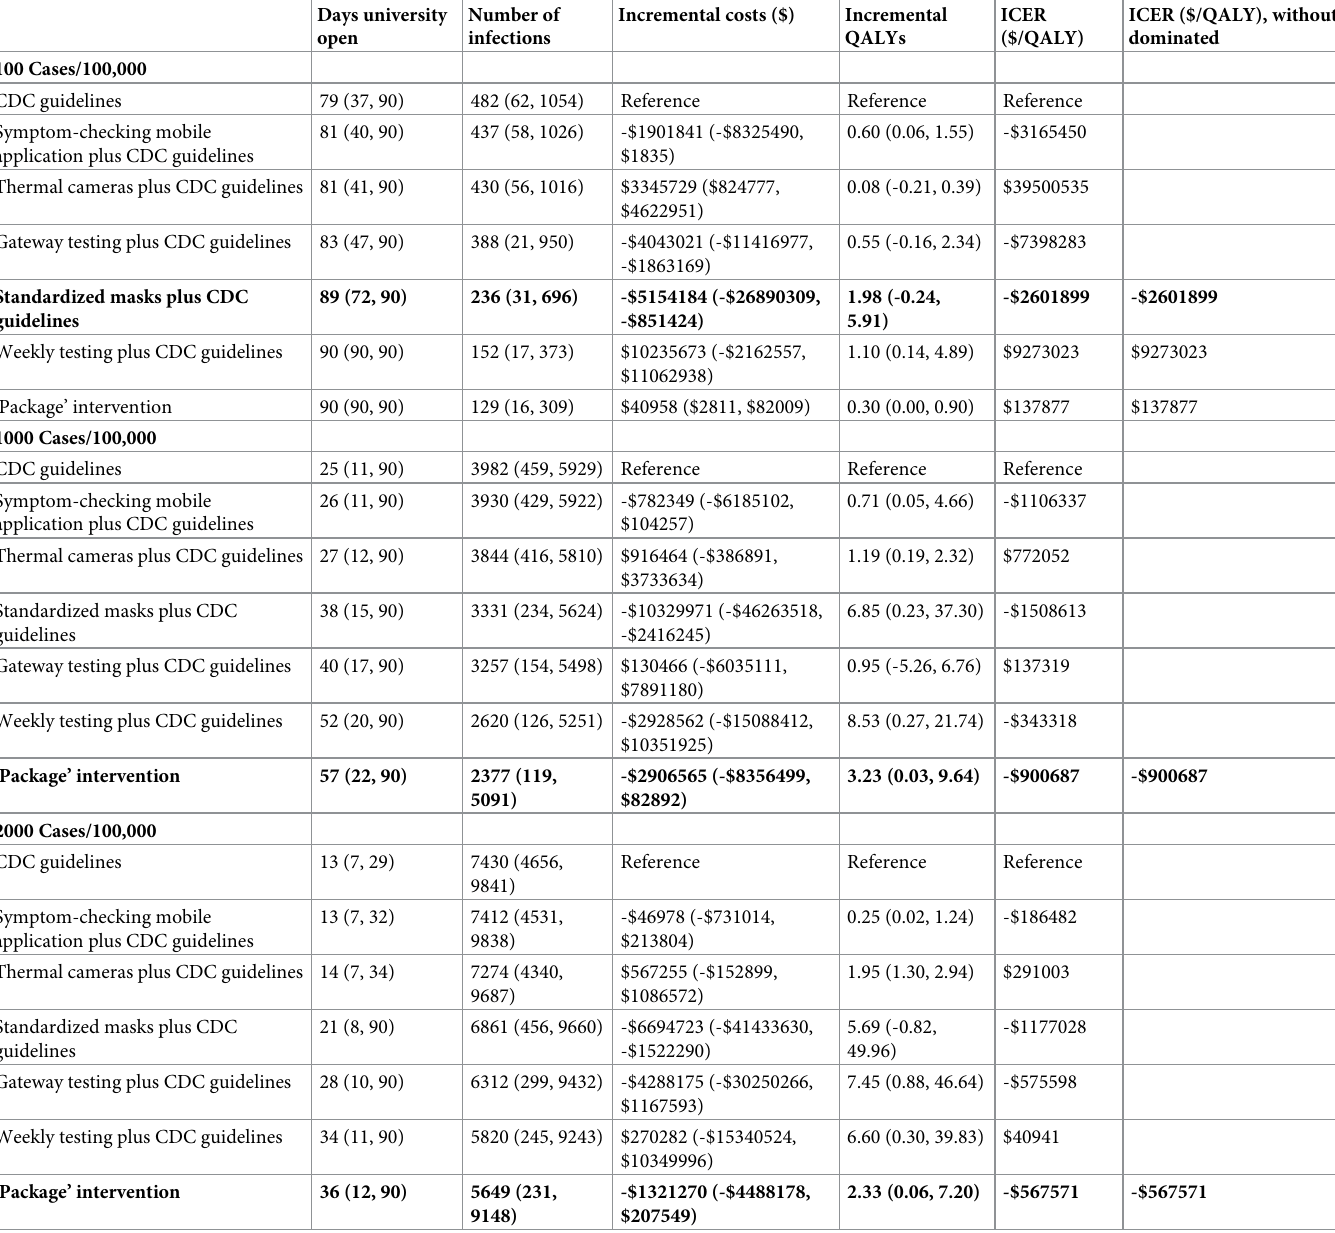
Table 3. Model outcomes for average number of days that the university will remain open, costs, Quality-Adjusted Life Years (QALYs), and Incremental Cost-Effec- tiveness Ratio